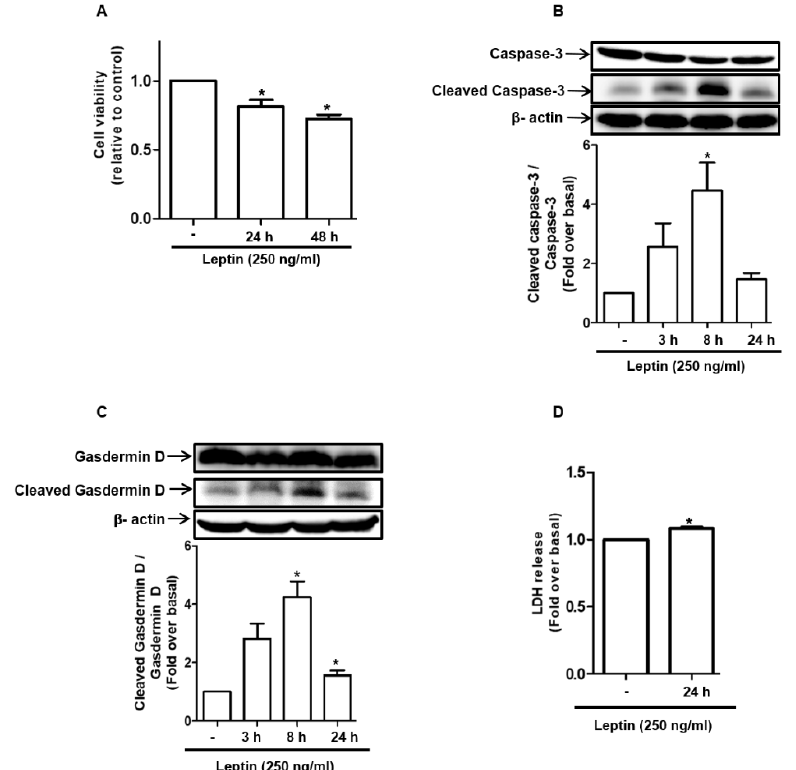
Figure 1. Cytotoxic effects of leptin in rat hepatocytes: Rat hepatocytes were isolated and treated with leptin (250 ng/mL) for the indicated time periods. ( A ) Cell viability was determined by MTS assay. ( B ) Cleaved and total caspase-3 levels were measured by Western blot analysis. Representative images from three independent experiments are shown along with β -actin as an internal control. Expression levels of active caspse-3 were quantitated by densitometric analysis and presented in the lower panel. ( C ) Total and cleaved gasdermin D expression levels were determined by Western blot analysis. Representative images from three independent experiments are shown. Expression levels of cleaved gasdermin D were quantified by densitometric analysis and are presented in the lower panel. ( D ) Cell culture media were collected and used to measure the levels of LDH released. Values are presented as fold changes compared to the control group and are expressed as mean ± SEM, n = 3. * denotes p < 0.05 compared with control cells.